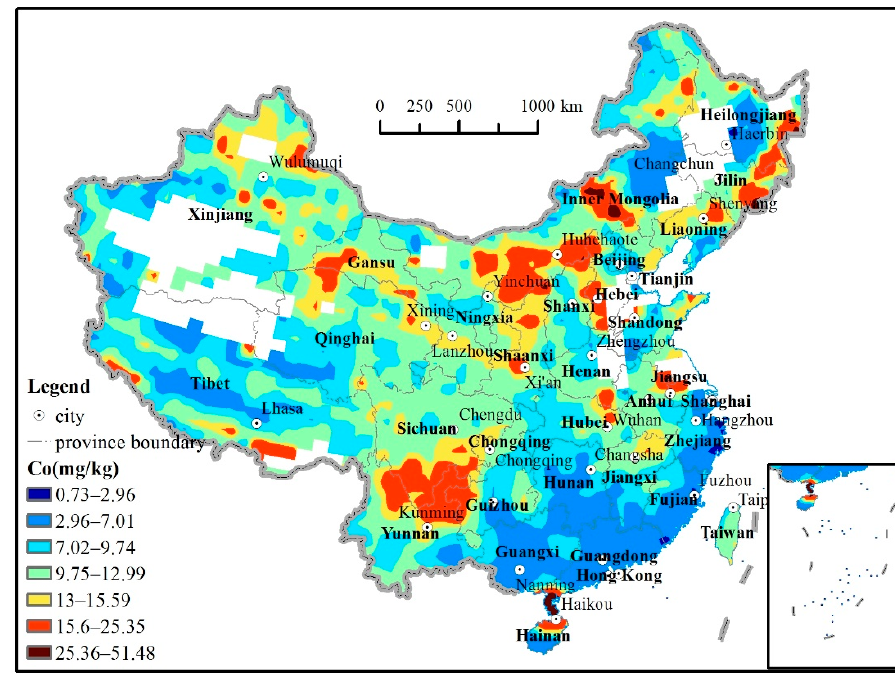
Figure 5. Petrogeochemical map of cobalt of exposed crust in China.